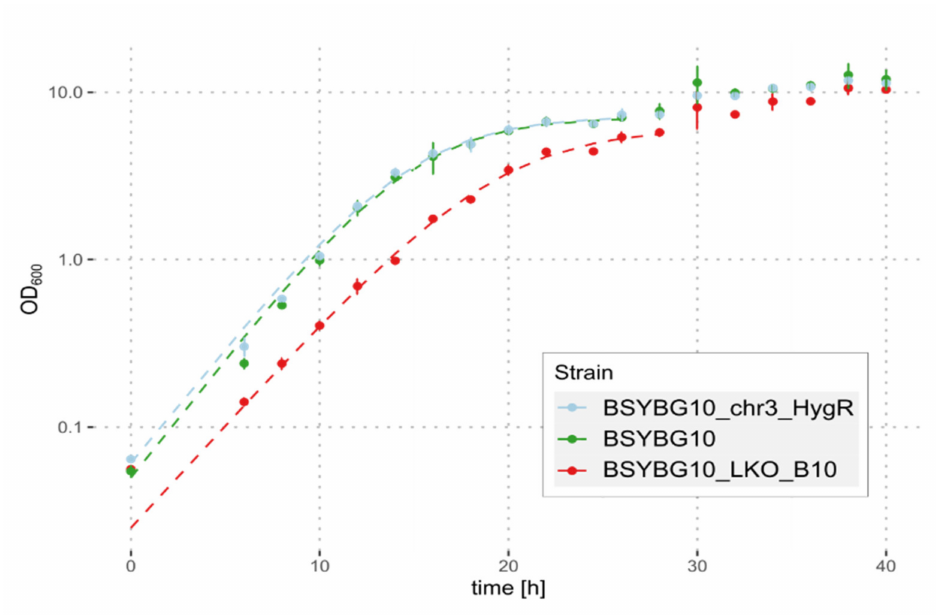
Figure 5. Growth of strains BSYBG10_LKO_B10, BSYBG10_chr3ne_HygR and the wildtype strain BSYBG10 in shake-flasks with glycerol as a carbon source. Mean values of 9 replicates are shown as dots and the error bars represent the standard deviation. Dashed lines represent the fitted growth curves based on the first 26 or 28 h,